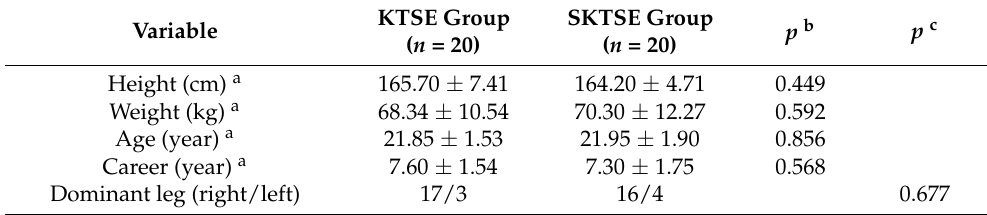
Table 1. General and clinical characteristics of